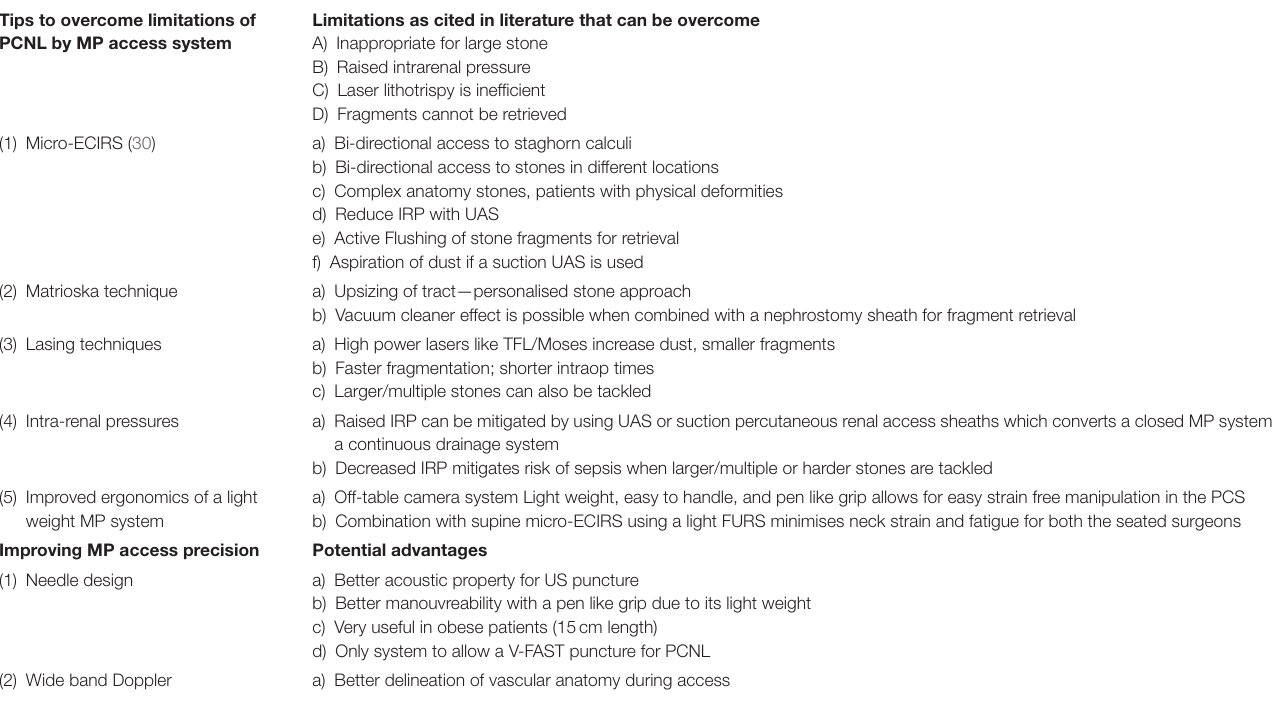
TABLE 1 | Salient advantages of PCNL by MP system and suggestions to overcome its limitations. Tips to overcome limitations of PCNL by MP access